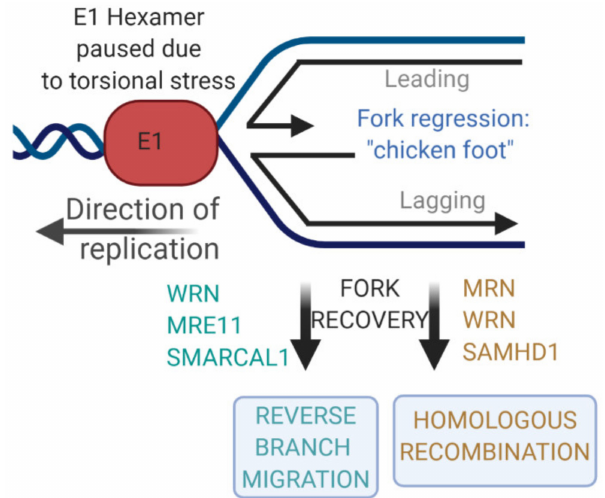
Figure 1. The E1 helicase pauses due to torsional stress on the viral genome undergoing replication. During replication this potentially causes fork regression, generating a chicken foot structure. This structure can be resolved without introducing a double-strand DNA break via reverse branch migration or homologous recombination. Some of the factors involved in these processes are highlighted. Please see Section 5 below for a more detailed description of the role of WRN (Werner helicase) in regulation of E1–E2 DNA